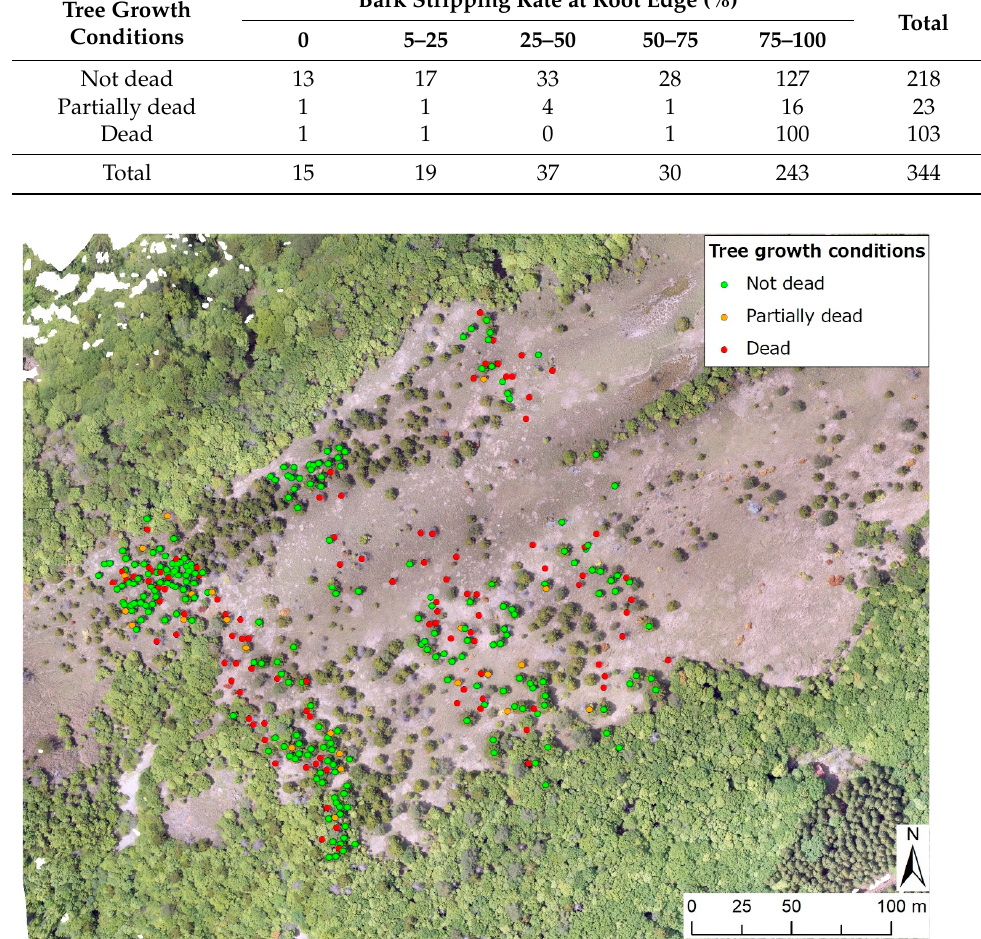
Figure 4. Growth conditions of Abies homolepis.